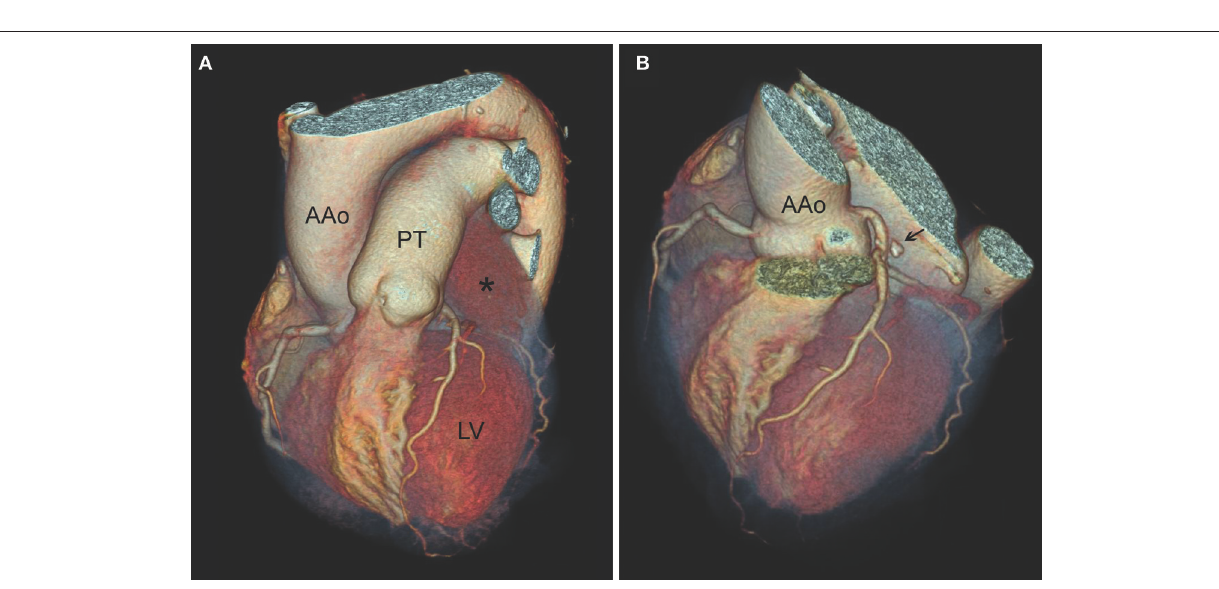
FIGURE 2 | Heart computed tomography, 3-dimensional reconstruction. (A) The tumor (asterisk) is located posteriorly and laterally to the pulmonary trunk (PT) and the ascending aorta (AAo), superiorly to the left ventricle (LV). (B) Macrocalcificacion (black arrow) as a part of the tumor’s